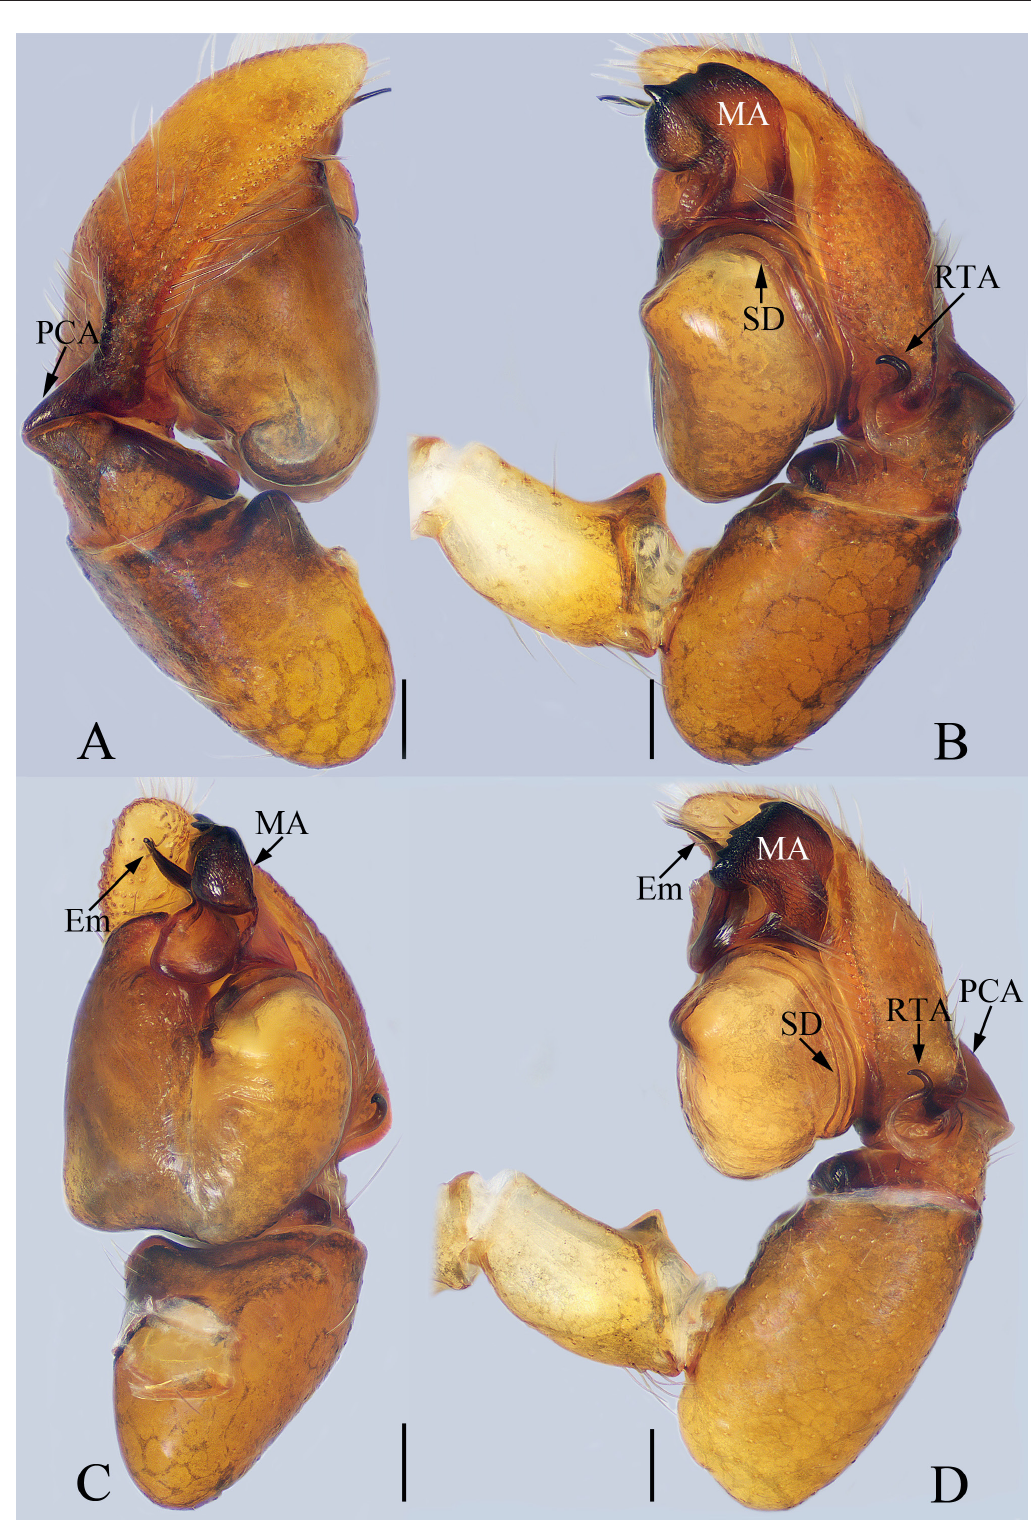
Fig. 11. Male palp of Synagelides subgambosus sp. nov. and S. gambosus Xie & Yin, 1990. A – C . S. subgambosus , holotype, ♂ (TRU-Salticid-0028). D . S. gambosus , ♂ (TRU-Salticid-0052). A . Prolateral view. B , D . Retrolateral view. C . Ventral view. Abbreviations: see Material and methods. Scale bars = 0.1